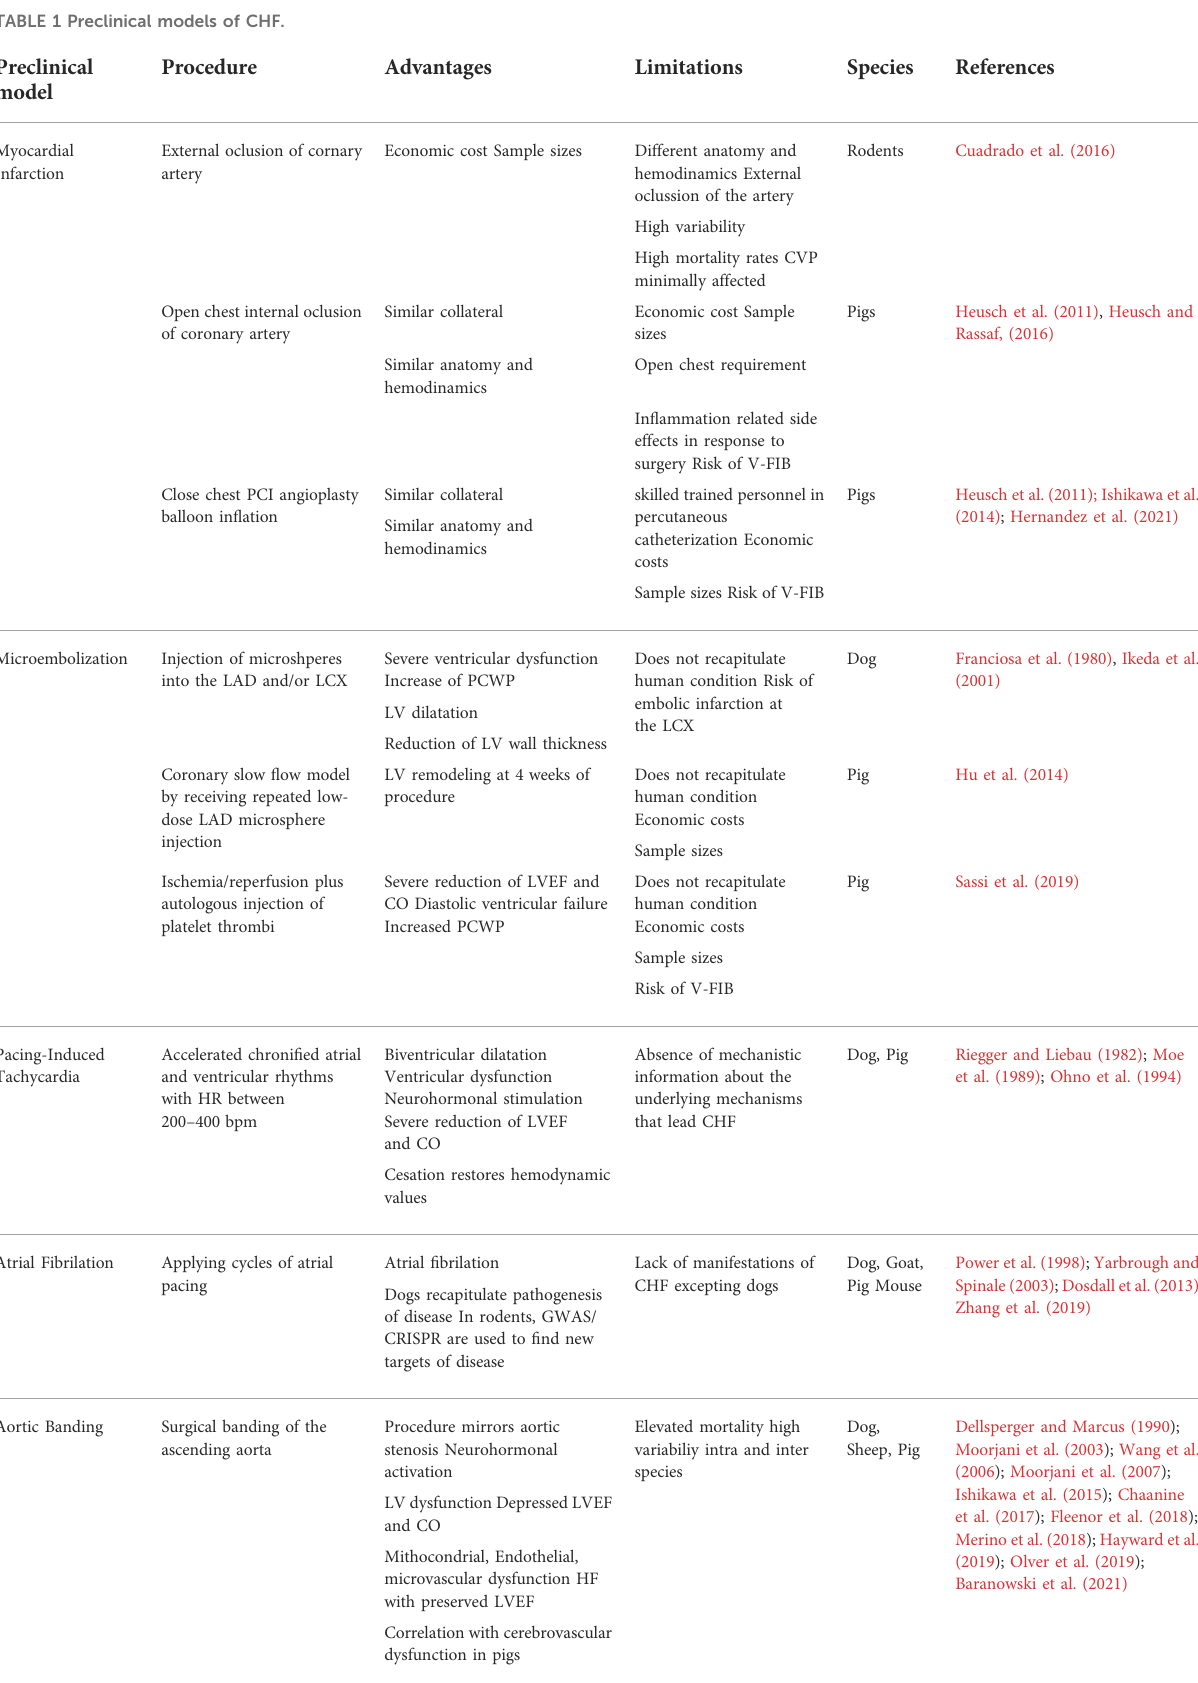
TABLE 1 Preclinical models of